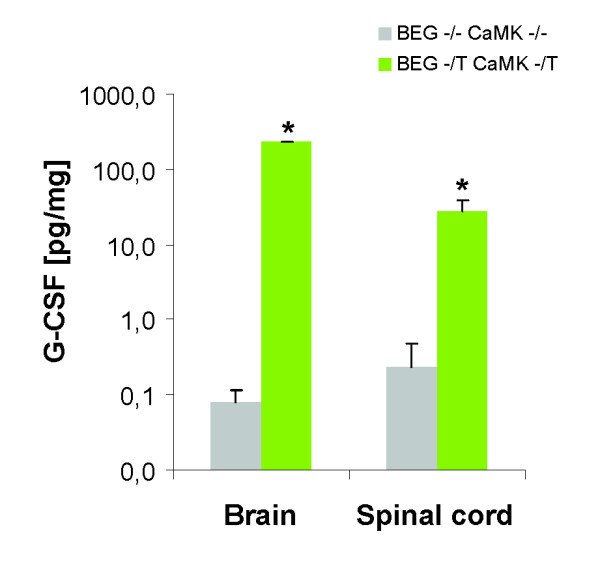
G-CSF concentration in the CNS. Levels of G-CSF are higher in the brain and in the spinal cord of mice overexpressing G-CSF (BEG -/T CaMK -/T) compared to wild type littermate controls (BEG -/- CaMK -/-). G-CSF proteins were quantified by ELISA with protein lysates from brain or spinal cord (n = 3, *p < 0.05).